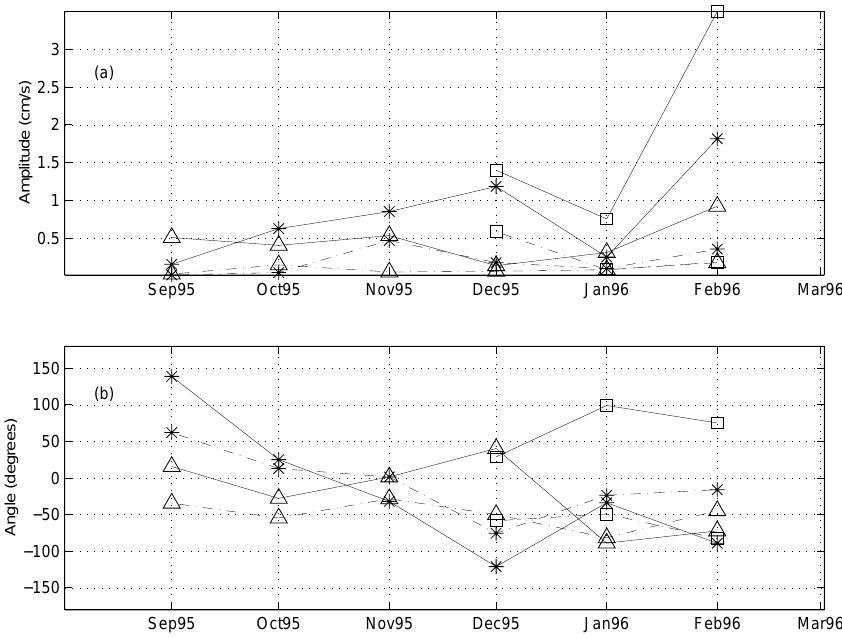
Fig. 4. (a) Semi-major (solid line) and semi-minor (dashed line) axis of the M2 tidal component calculated for periods of one month each for current-meters at station H10. Squares indicate the surface current-meter (26m depth), stars are the intermediate ones (76m depth), and triangles are the bottom ones (220m depth). (b) The same as for (a), but for phase (solid line) and orientation (dashed line). Angles are given in a trigonometric coordinate